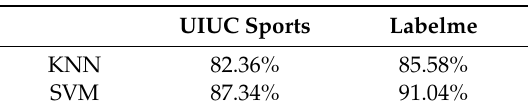
Table 1. Recognition accuracy of different classifiers.